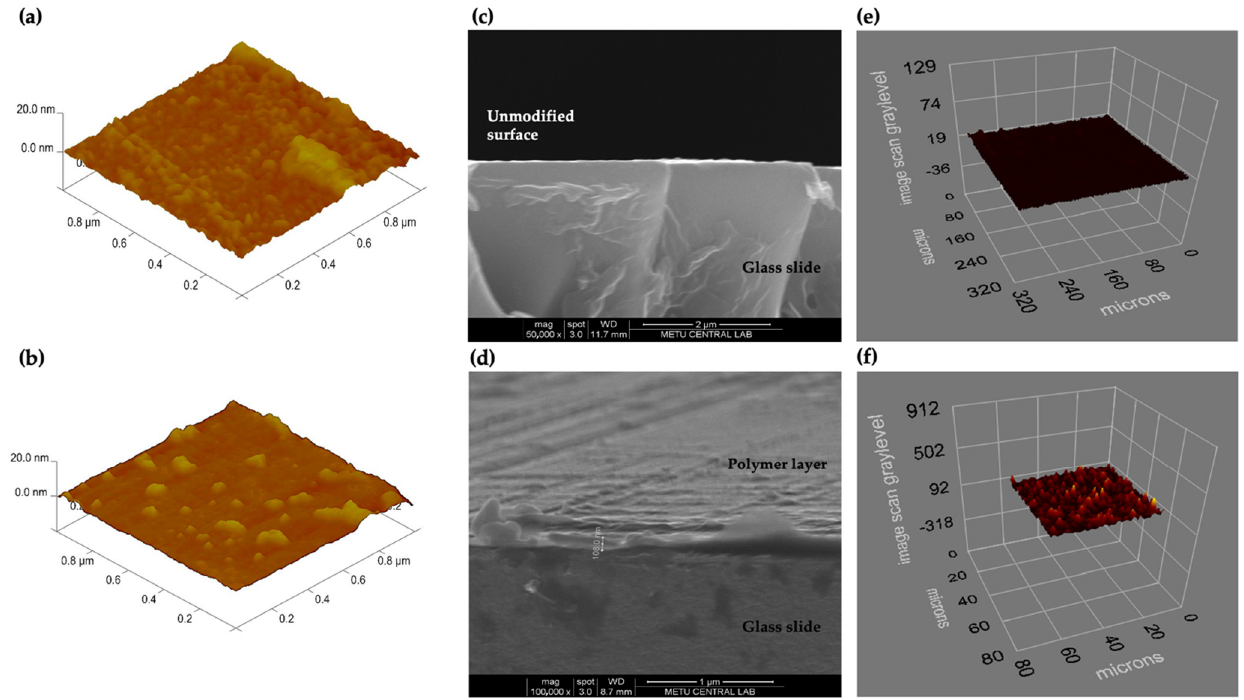
Figure 3. ( a ) MIP, ( b ) NIP AFM images; ( c ) unmodified surface, ( d ) MIP nanofilm surface SEM image; and ( e ) bare SPR chip, ( f ) MIP SPR chip ellipsometer images.